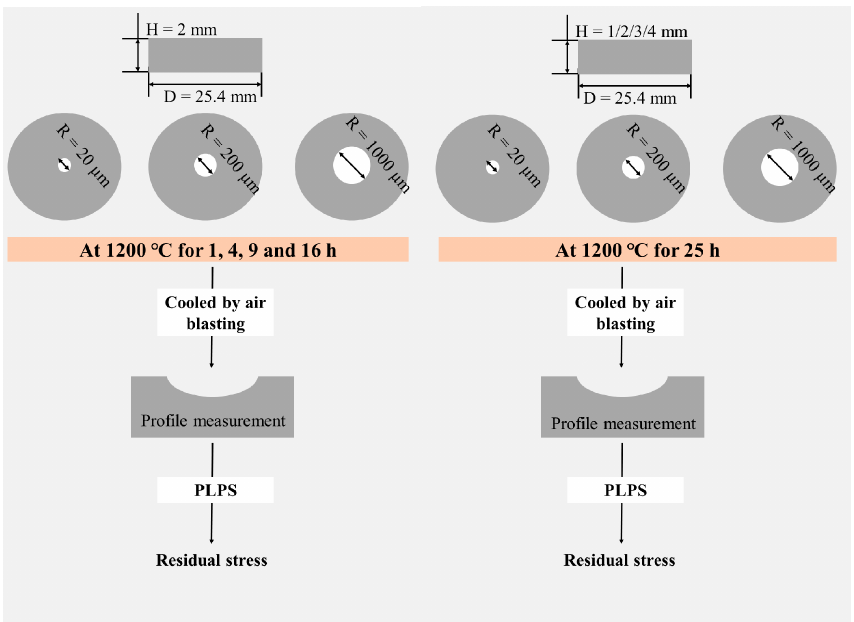
Figure 1. Experimental process diagram.